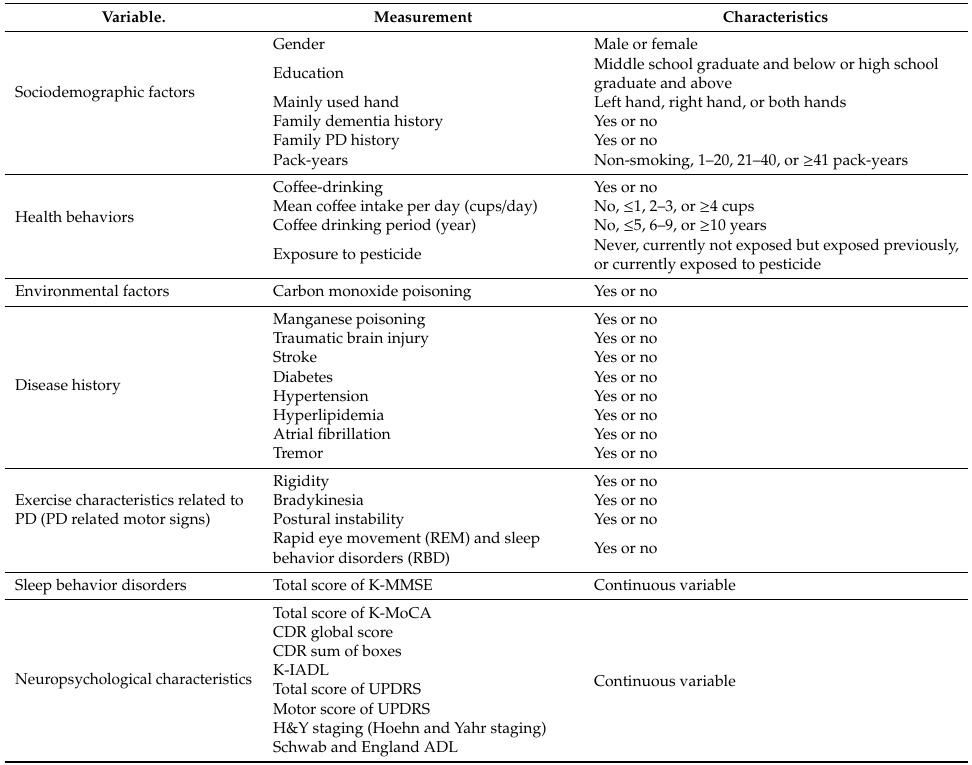
Table 1. Measurement and definition of